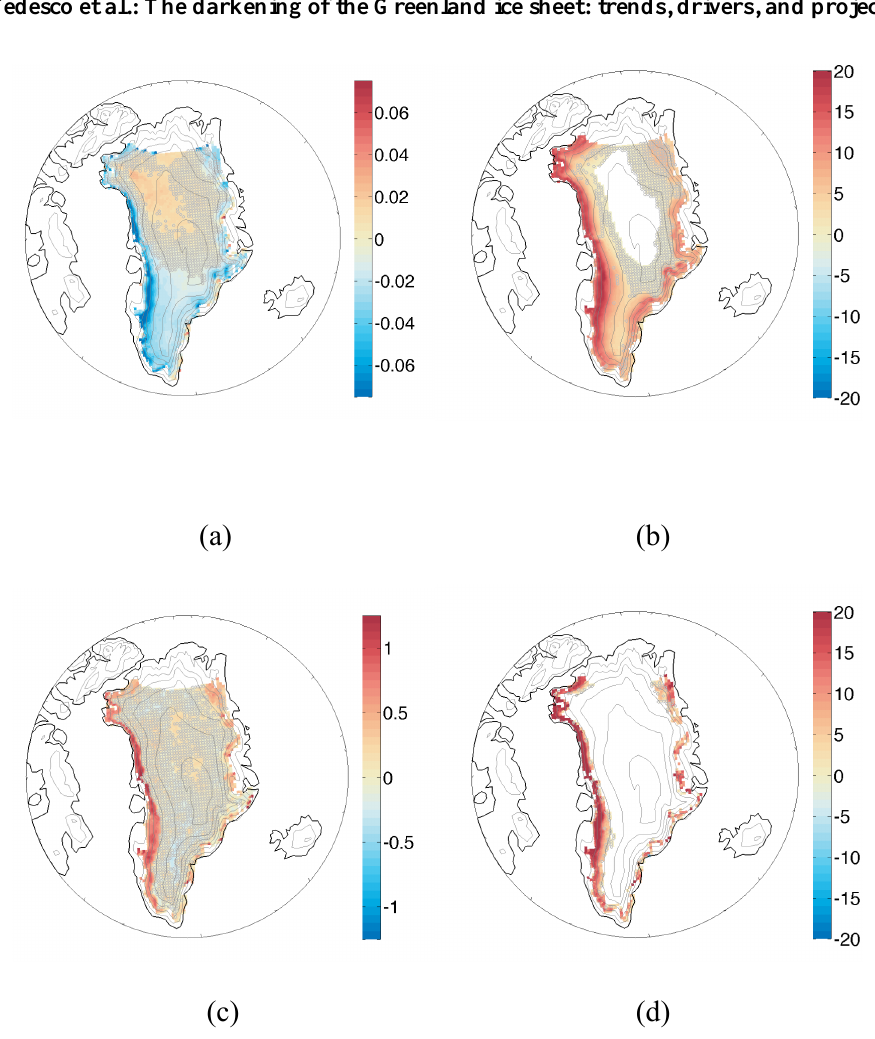
Figure 2. Maps of JJA trends (per decade) from 1996 to 2012, when darkening began to occur, for (a) space-borne-estimated GLASS albedo, (b) number of days when MAR-simulated surface air temperature exceeded 0 ◦ C, (c) MAR-simulated surface grain size, and (d) number of days when bare ice is exposed as simulated by MAR. Regions where trends are not significant at a 95% level are shown as grey-hatched areas. White regions over the north end of the ice sheet indicate areas which were not viewed by the